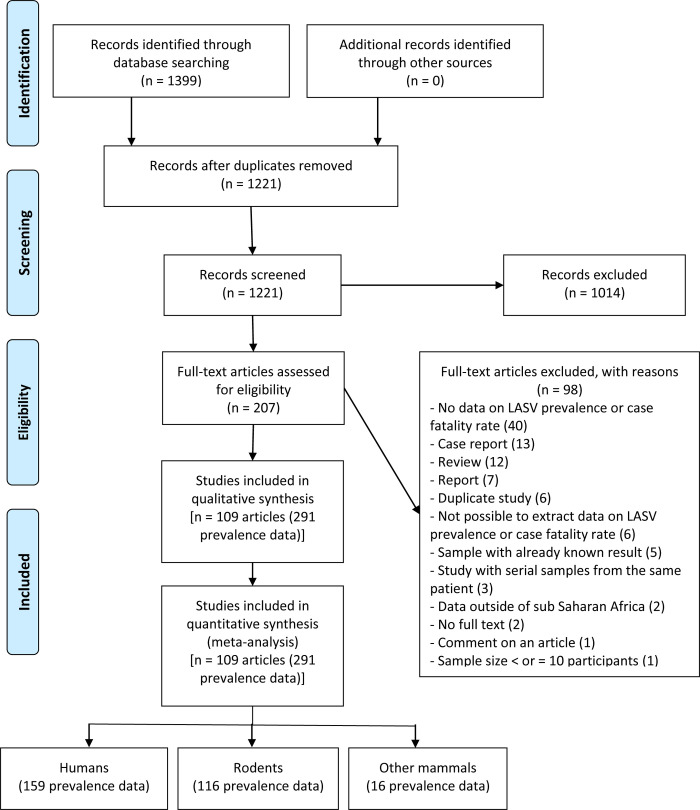
Flow-chart describing study selection process.